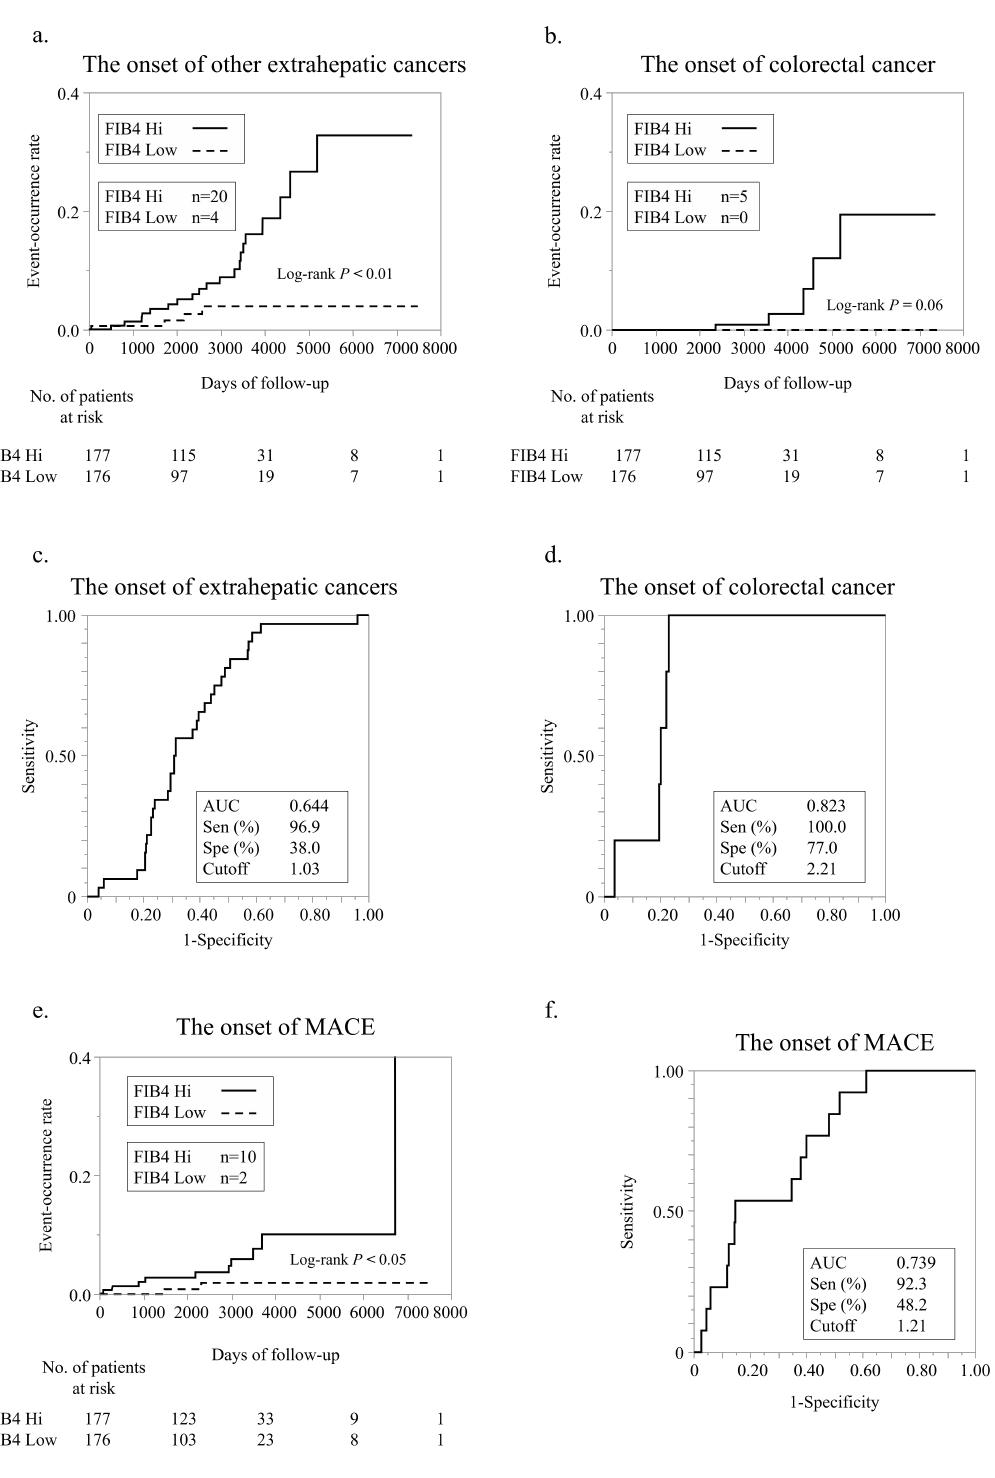
Figure 4. Extrahepatic cancer development according to FIB-4 index. ( a ) Comparison of new ex- trahepatic cancer development according to FIB-4 index. ( b ) Comparison of new colorectal cancer development according to FIB-4 index. ( c ) ROC analysis of FIB-4 index for extrahepatic cancer development. ( d ) ROC analysis of FIB-4 index for colorectal cancer development. ( e ) Compar- ison of new MACE development according to FIB-4 index. ( f ) ROC analysis of FIB-4 index for MACE